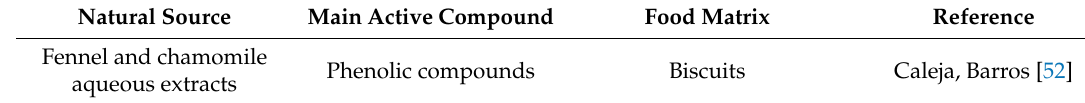
Table 4. Applications of natural antioxidants in food